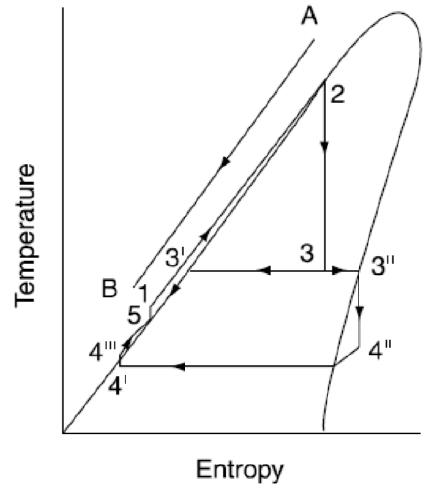
Figure 7. T – s diagram of Smith cycle [24].